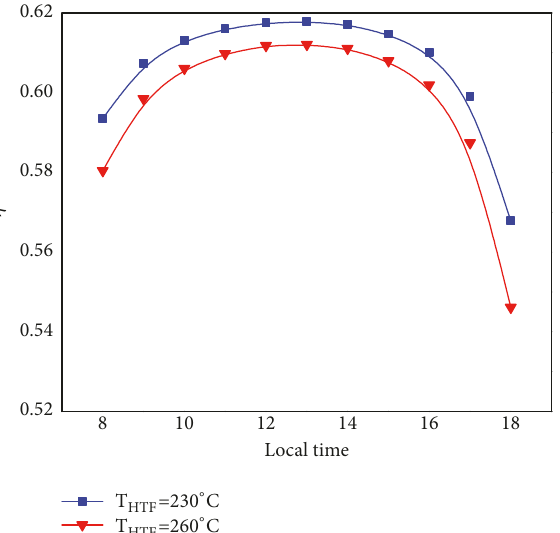
Figure 10: Collector efficiency during typical Tunisian summer day for different HTF temperatures.